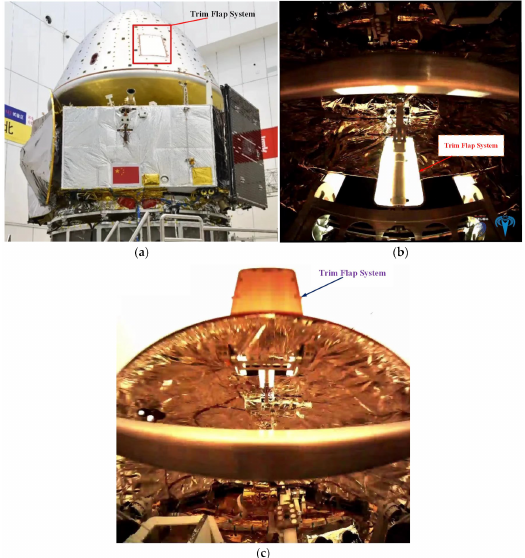
Figure 17. The trim flap system mounted on Tianwen-1 Mars probe: ( a ) Stowed configuration prior to launch; ( b ) Stowed configuration before the EDL phase; ( c ) Fully deployed configuration during the EDL